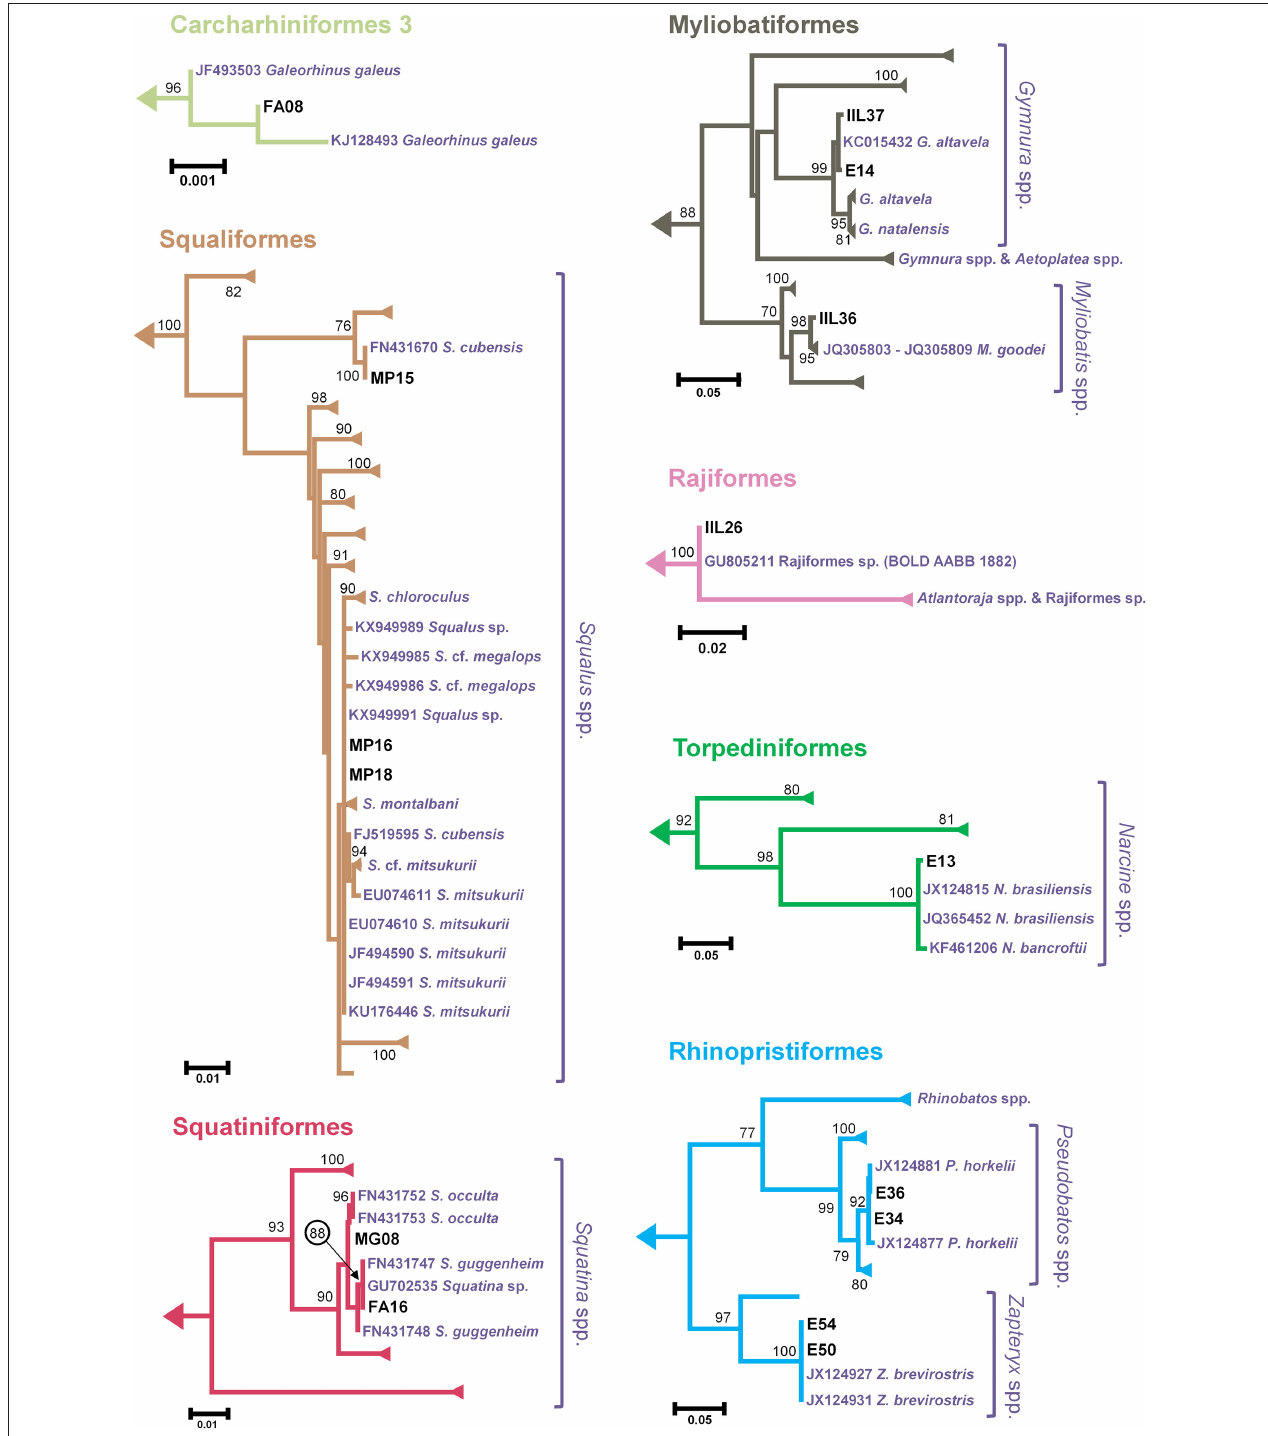
FIGURE 2B | ML tree based on HKY + G + I distance. The miniature on the upper left side shows major groups, displayed in more detail in individual panels. The number of shark and ray symbols represent the number of different species identified in the study for each group. Please note that this is an unrooted tree. Most entries were collapsed and the names were omitted for clarity. Samples from the present study are labeled according to Table 1 . The most likely candidate species, together with other closely related species are shown in red. The numbers above the branches represent bootstrap percentage based on 1,000 replicates. Bootstrap values < 70 were omitted. Please note the different scale among panels. The full ML tree is available as Supplementary Material (File S3).